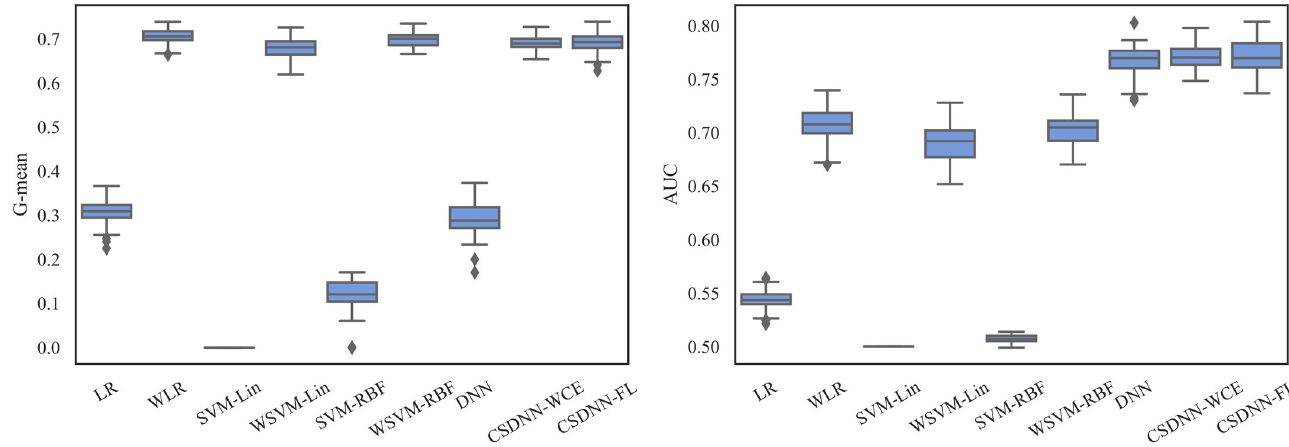
Fig 29. Robustness of CSDNN-FL and CSDNN-WCE in comparison to other ML algorithms for MOMI dataset in terms of G-mean (left) and AUC (right).